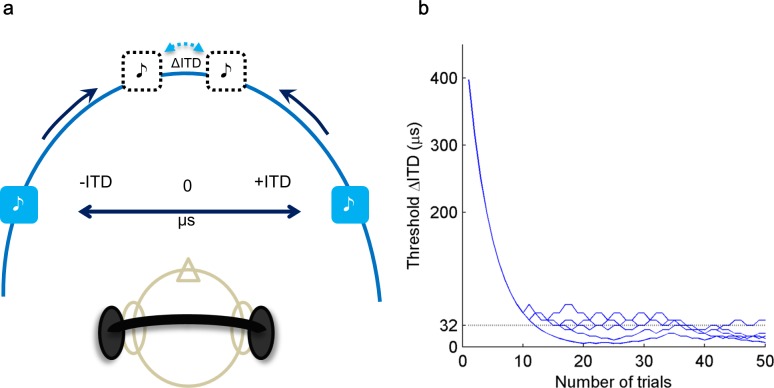
Schematic representation of Task 1 ITD lateralization procedure.(a) depicts lateralization task and (b) shows an example of ITD threshold tracking pattern from 1 participant. Dashed line (b) indicates ITD threshold averaged from 4 adaptive tracks.